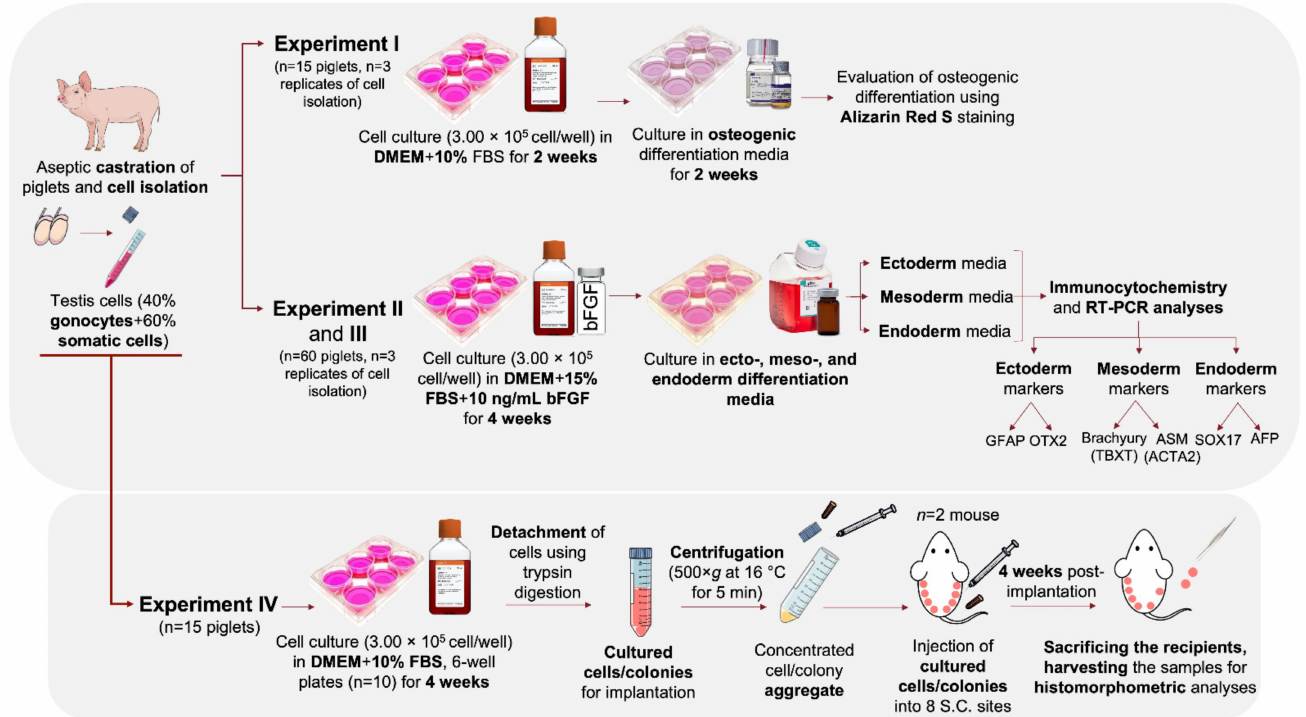
Figure 1. Schematic representation of the experimental design. In Experiment I, differentiation of neonatal porcine gonocytes to osteogenic pathway was investigated. Gonocytes were isolated from neonatal piglets and cultured in regular media for 2 wk to induce dedifferentiation. Media was then changed to osteogenic differentiation media to direct their differentiation into osteogenic cells. Cells and colonies were stained with Alizarin Red S for confirmation of osteogenic differentiation. In Experiment II and III, to induce tri-lineage differentiation, porcine gonocytes were cultured in regular media for 4 wk to induce dedifferentiation. Cells and colonies were then cultured in ectoderm, mesoderm, or endoderm differentiation media to direct their differentiation into the respective cell derivates. Tri-lineage differentiation was confirmed by immunocytochemistry and RT-PCR analyses against markers associated with formation of ectoderm, mesoderm, and endoderm. The pluripotency and tumorigenicity of cultured gonocytes and their colonies were also investigated using an implantation assay (Experiment IV). Isolated testis cells were cultured for 4 wk in DMEM + 10% FBS, dislodged from culture wells, and injected into the subcutaneous tissue of immunodeficient recipient mice. After 4 wk, recipient mice were sacrificed, and implants were retrieved for histomorphometric